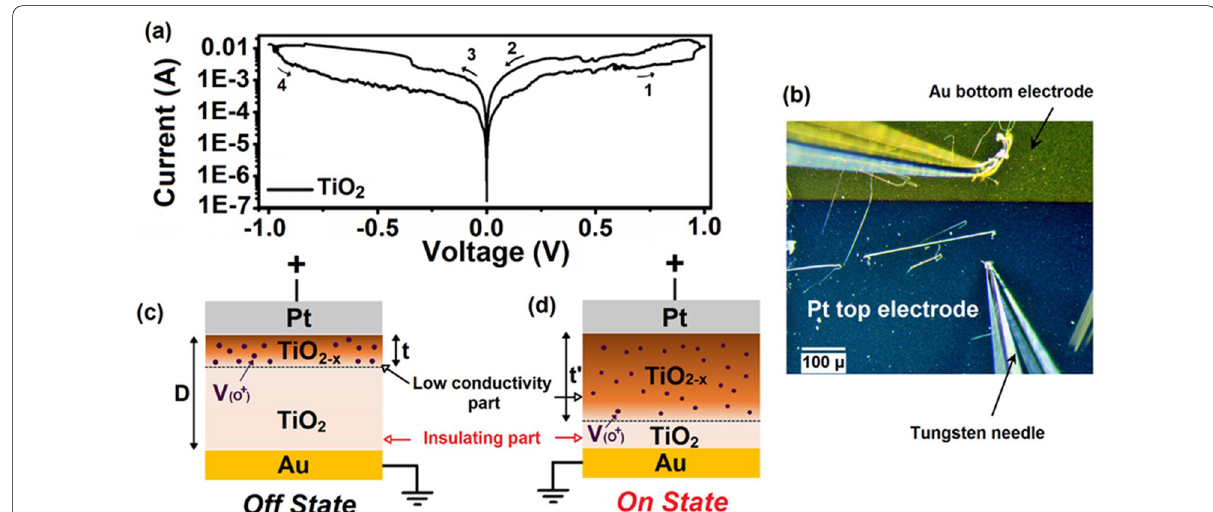
Fig. 16 a Typical logarithmic scale depiction of I–V sweeping graph of Pt/In-doped TiO 2 /Au memristor. b Device is set off, the metallic cations are distributed in top layer of In-doped TiO 2 film. c The formation of filamentary conductive channels, the device is set On (Set, stage 1). d The depletion of metallic cations adjacent to the bottom electrode. The device is set off again (Reset, stage 2). e By imposing the reverse gate voltage, the metallic cations again move toward the cathode electrode (top Pt electrode) and again form a metallic cation bridge and the device is set On (Set-stage 3). f By depletion of metallic cations, at Pt electrode the device is set off again (Reset, stage 4). Reprinted with permission form